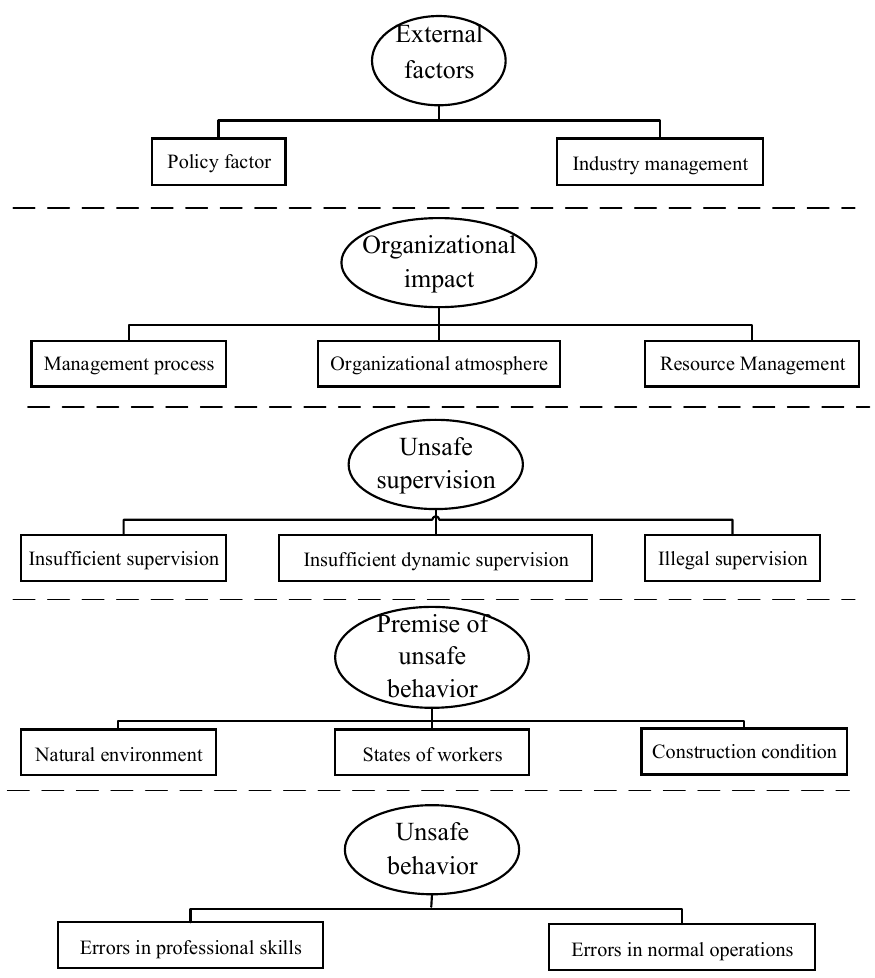
Figure 3. Prefabricated building hoisting construction HFACS frame. Table 1. Causation factors of prefabricated building hoisting construction accidents based on im- proved HFACS frame.